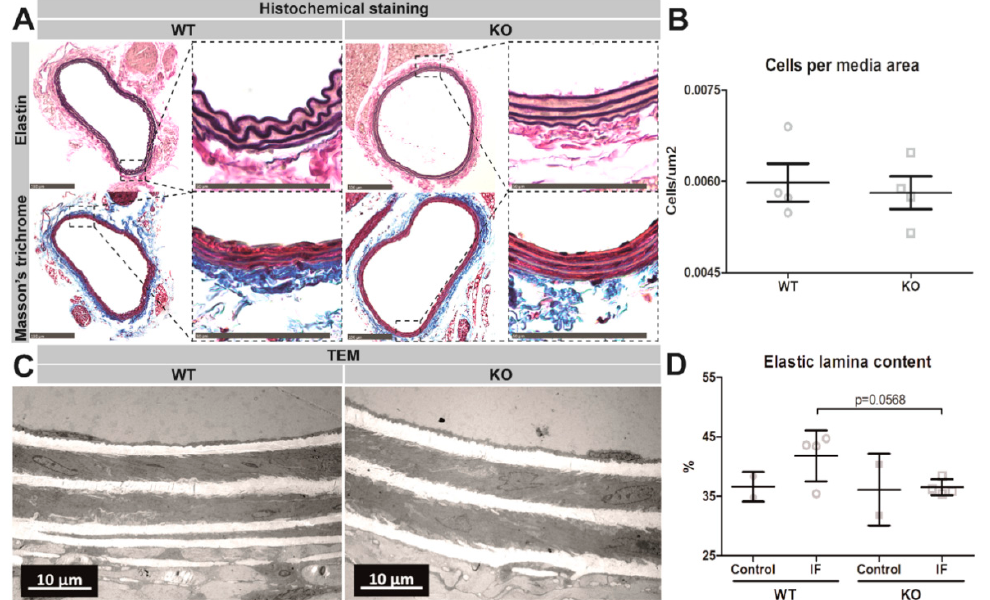
Figure 4. The influence of PCSK6 on cell density and elastic laminae content in the right common carotid artery. Representative images from WT and KO carotid arteries exposed to increased flow using histochemical staining with ( A ) Weigert’s elastin and Masson’s trichrome (WT n = 4, KO n = 4). Images from Masson’s trichrome staining were used to ( B ) quantify the number of nuclei per media area in the outward remodeled vessels. Further evaluation was performed using transmission electron microscopy on pressure-fixed right CCAs 6 weeks after exposure to increased blood flow in ( C ) WT and KO mice. Quantification was performed by measurements of ( D ) elastic laminae content per media area during normal (WT n = 2, KO n = 2) and increased flow (WT n = 4, KO n = 4) conditions. Data expressed as mean ± standard deviation. * p < 0.05 calculated with Mann-Whitney test. CCA = common carotid artery. IF = increased blood flow. KO = Pcsk6 − / − mice. TEM = transmission electron microscopy, WT = C57Bl/6J mice.